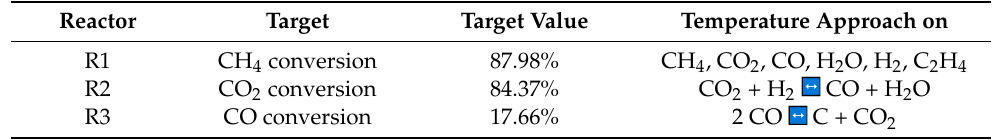
Table 5. Plasma torch model